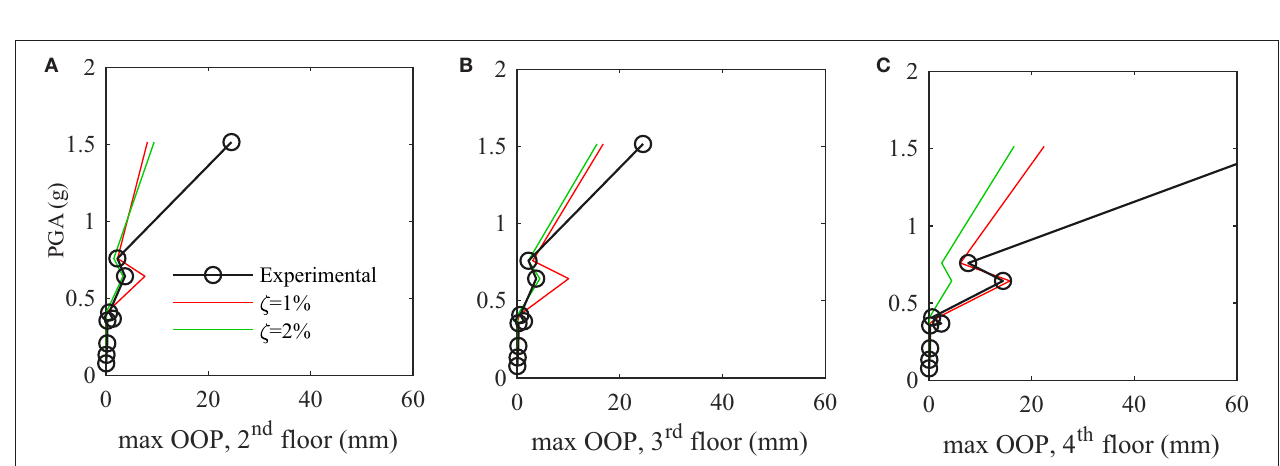
FIGURE 13 | Mixed RC/URM building: comparison of experimental and numerical out-of-plane displacements at (A) the second, (B) third, and (C) fourth stories for increasing levels of ground-motion intensities.